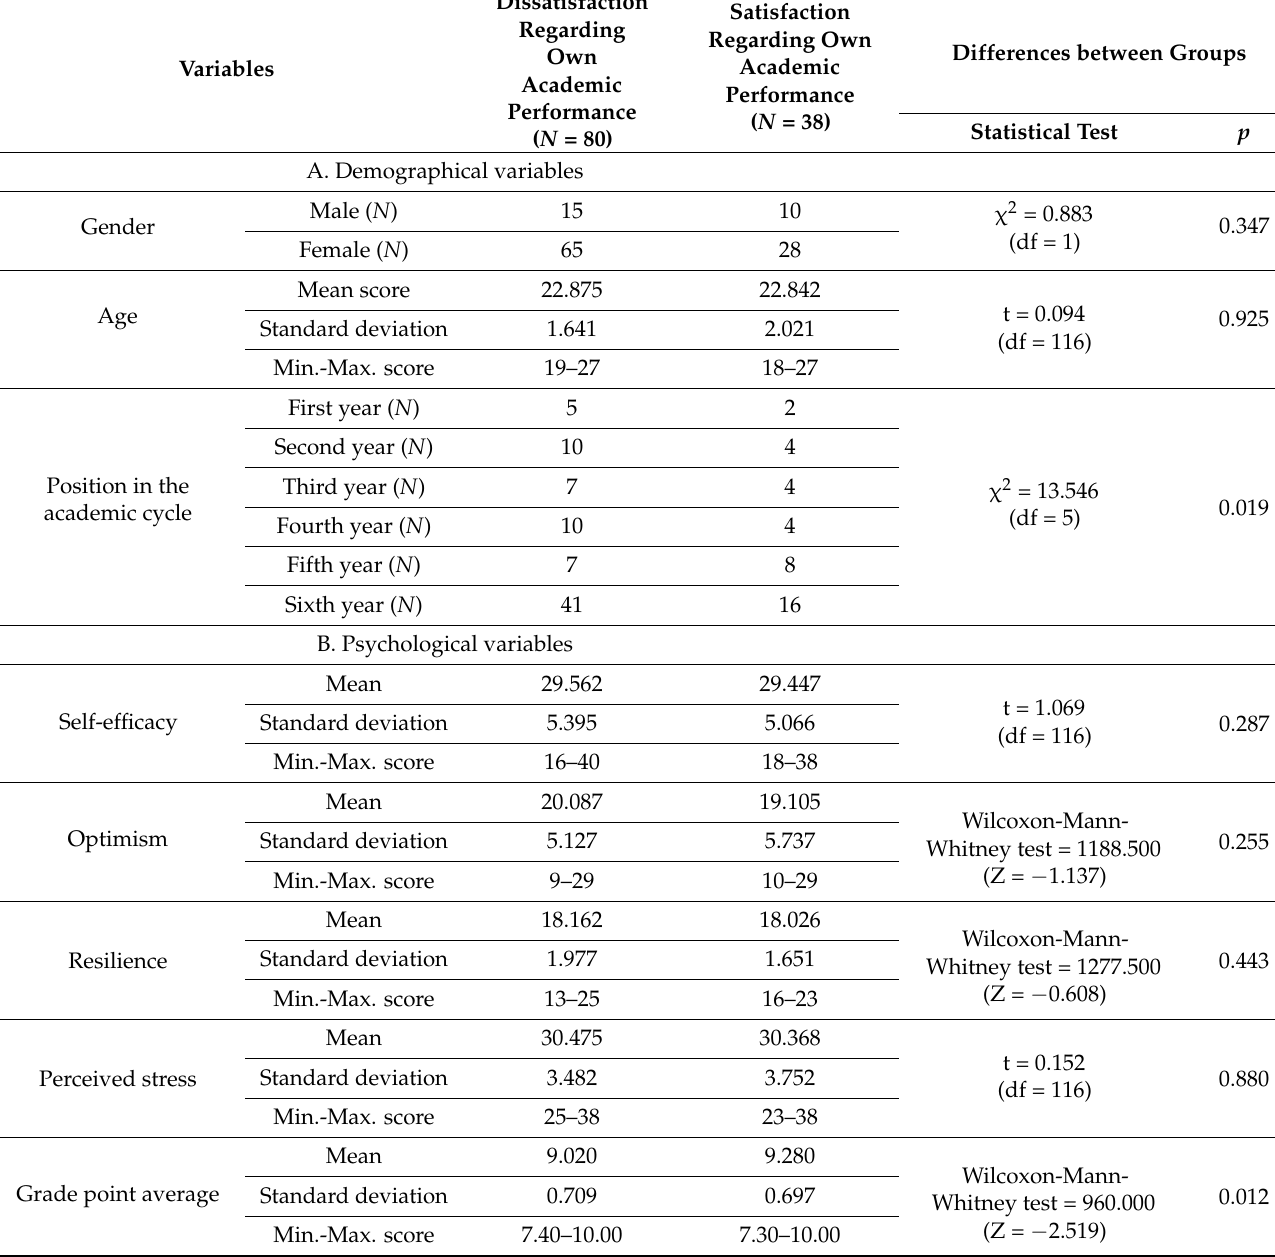
Table 8. Determinants of perceived academic